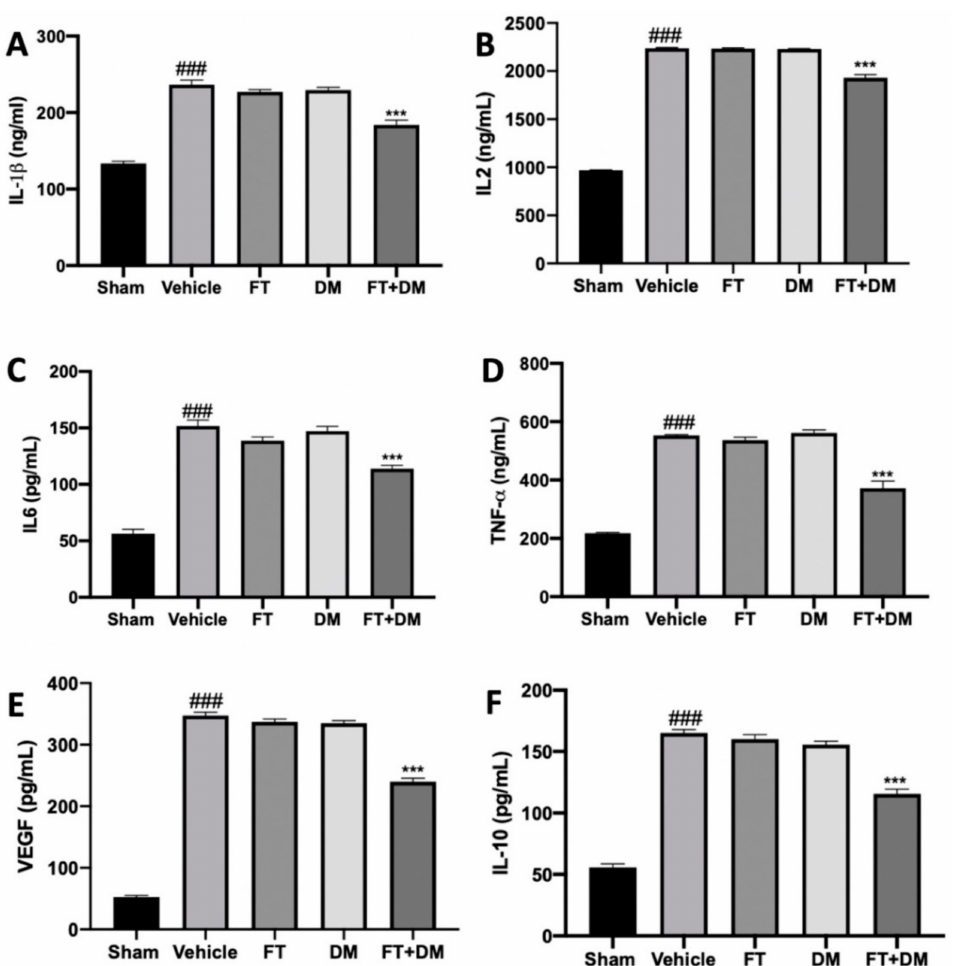
Figure 1. FT+DM administration reduced the levels of cytokines: IL-1 β ( A ), IL2 ( B ), IL6 ( C ), TNF- α ( D ), VEGF ( E ) and IL-10 ( F ) levels in peritoneal fluid. A p -value of less than 0.05 was considered significant: *** p < 0.001 vs. vehicle, ### p < 0.001 vs.